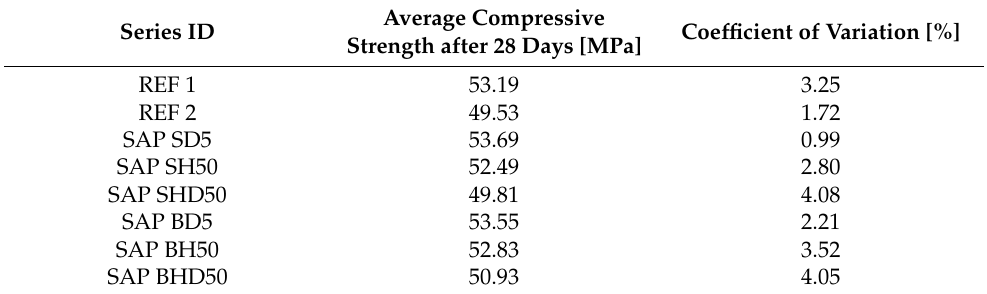
Table 7. The average compressive strength of SAP-modified and reference concrete series tested after 28 days of curing.